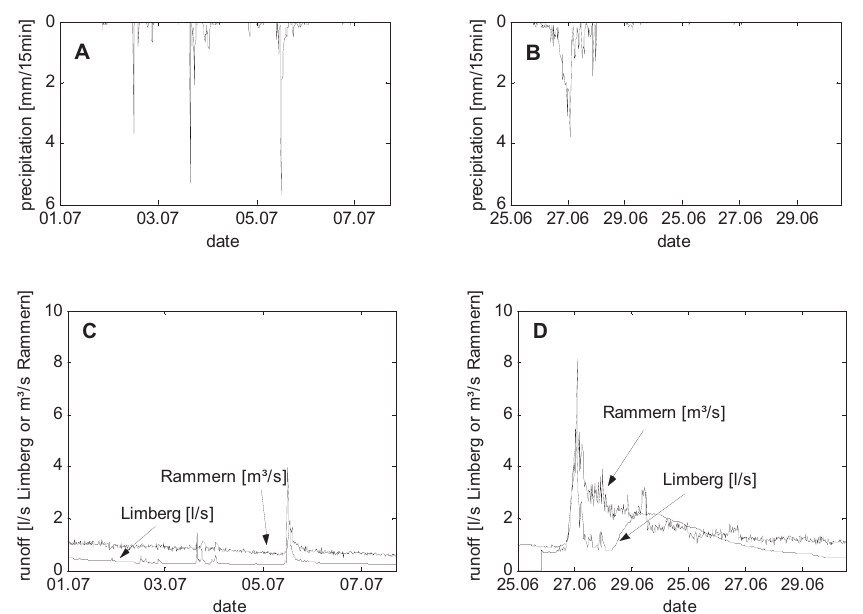
Fig. 2. Typical hydrographs of the micro-scale catchment at stream gauge Limberg and meso-scale catchment at stream gauge Rammern (year 1995): direct and synchronic runoff peaks (C) during short and intensive rainstorms (A) , and bimodal runoff events (D) during and after moderate and much longer rainfall events (B) (Kirnbauer et al., 2001,